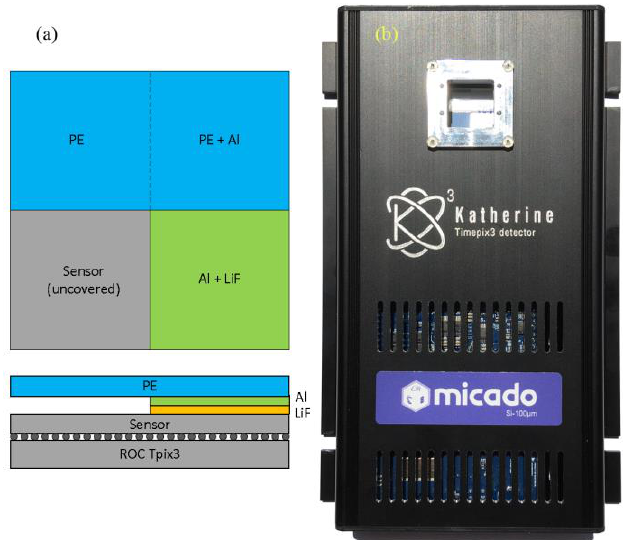
Fig. 1. (a) Structure of the converter (top and side view). (b) Housing of the Timepix3 detector and Katherine readout with the sensor window and the filter- holder in the upper part. Housing dimensions are 13 cm  20.4 cm  3 cm.